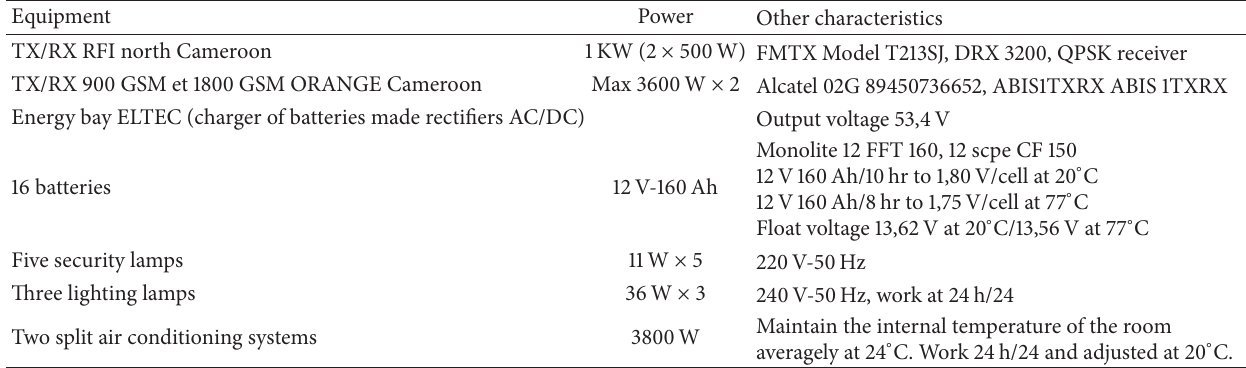
Table 3: Equipment of the RFI